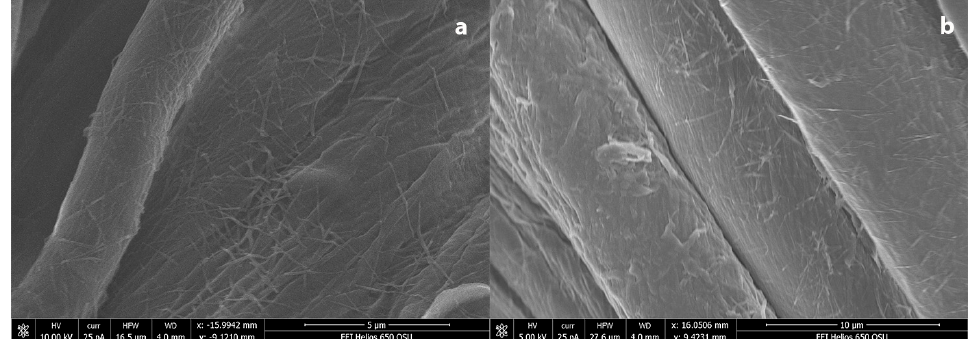
Figure 4. Results from the dripping and immersion testing, showing needle-like crystals on ( a ) Cotton treated with dripped ethanol-based ink, focused on a single fiber; ( b ) Immersion ethanol based-ink treatment on cotton, showing crystallization on several fibers. Images taken with a FEI Helios 650.